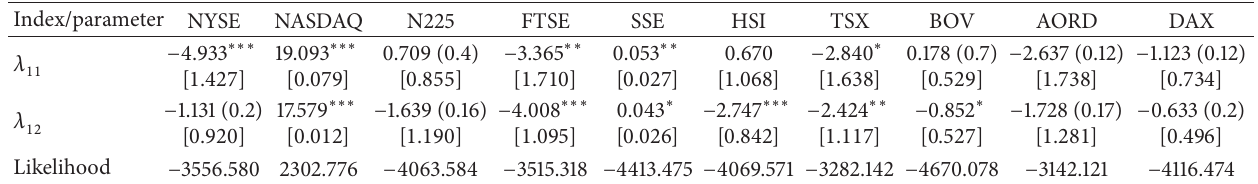
Table 12: Results of TVRAS-GARCH-M model ( 𝑃 30 𝑡 ).